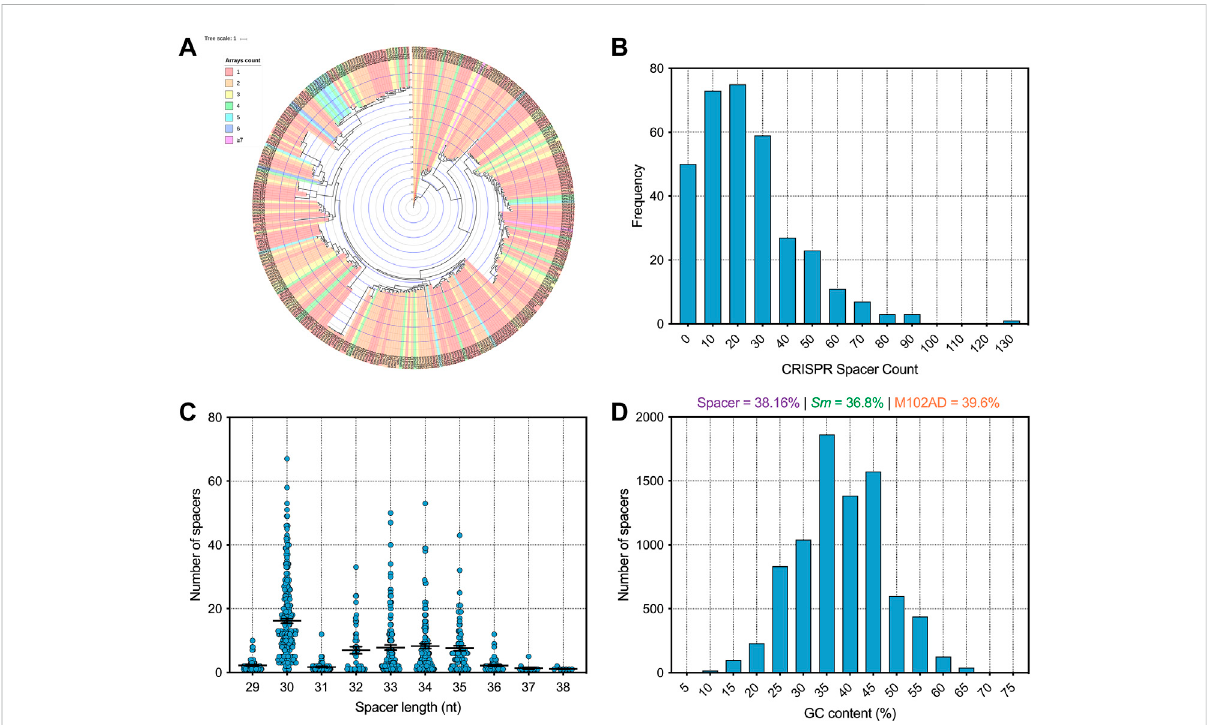
FIGURE 1 Analysis of S. mutans CRISPR spacers (A) A phylogenetic tree was generated using iTOL (Letunic and Bork, 2021) and strains were colored according to how many CRISPR spacer arrays were present on each strain genome (B) A frequency distribution of CRISPR spacer load across all the isolates (C) CRISPR spacers were grouped according to the length (nt) of the CRISPR spacers (D) A frequency distribution of CRISPR spacer GC content (percentage GC) was generated.